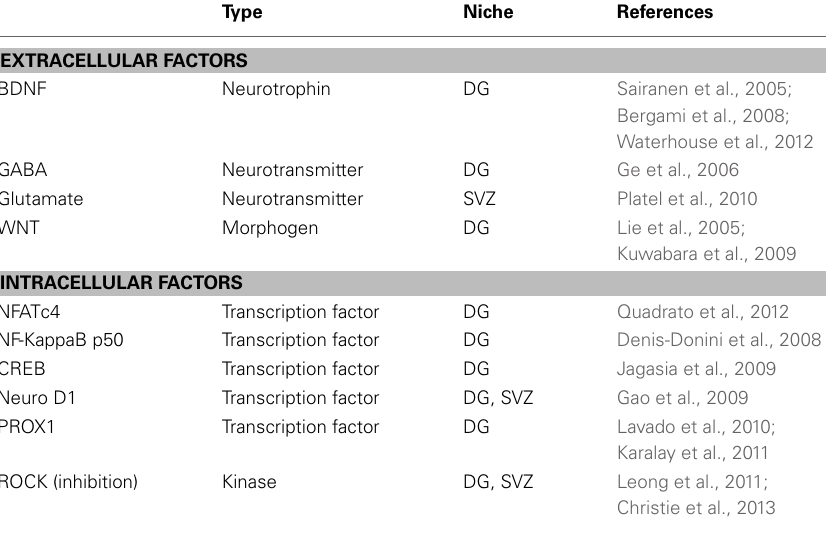
Table 1 | Factors required for newborn neurons survival and integration in physiological